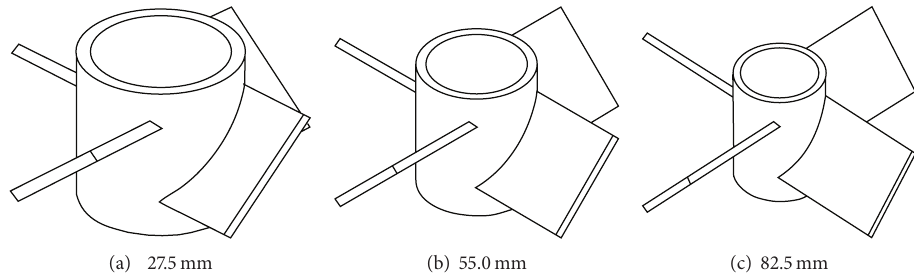
Figure 2: Details of Flat-blade impeller. All dimensions are in “mm.”